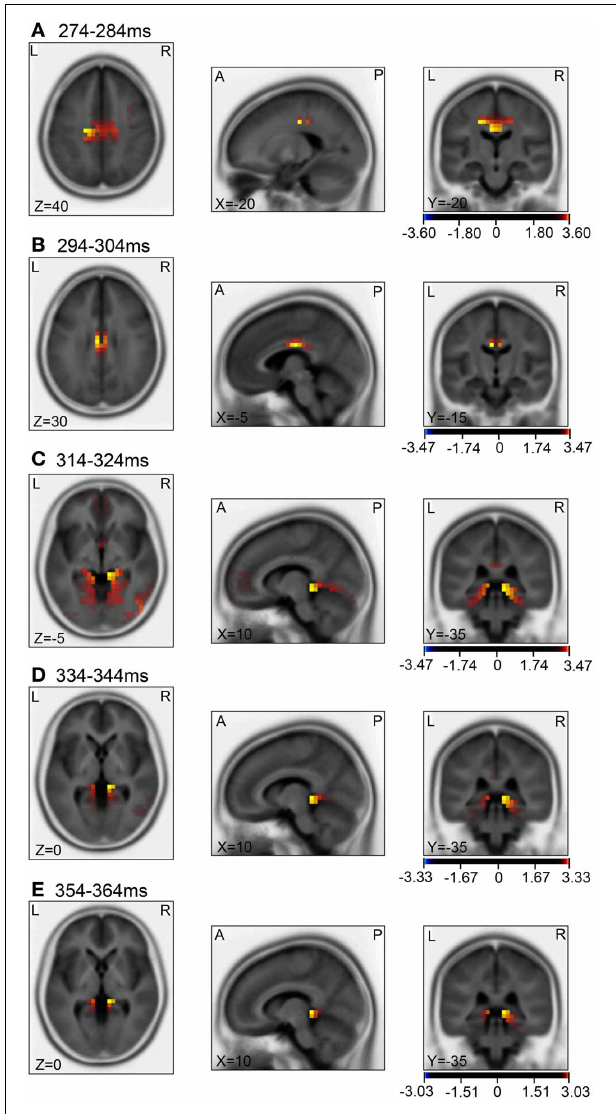
FIGURE 11 | sLORETA statistical nonparametric maps comparing the current source density of the ERPs between the control and test phases in the 5 time windows, 274–284ms (A), 294–304ms (B), 314–324ms (C), 334–344ms (D), 354–364ms (E), shown in Figure